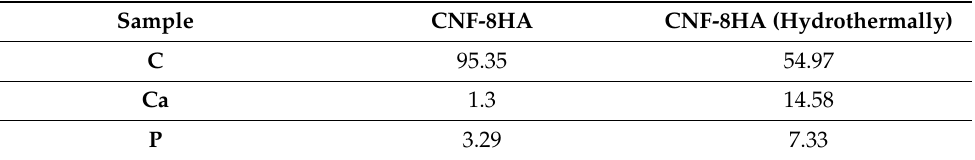
Table 2. Elemental analysis (EDX) of the modified carbon nanofibrous samples.